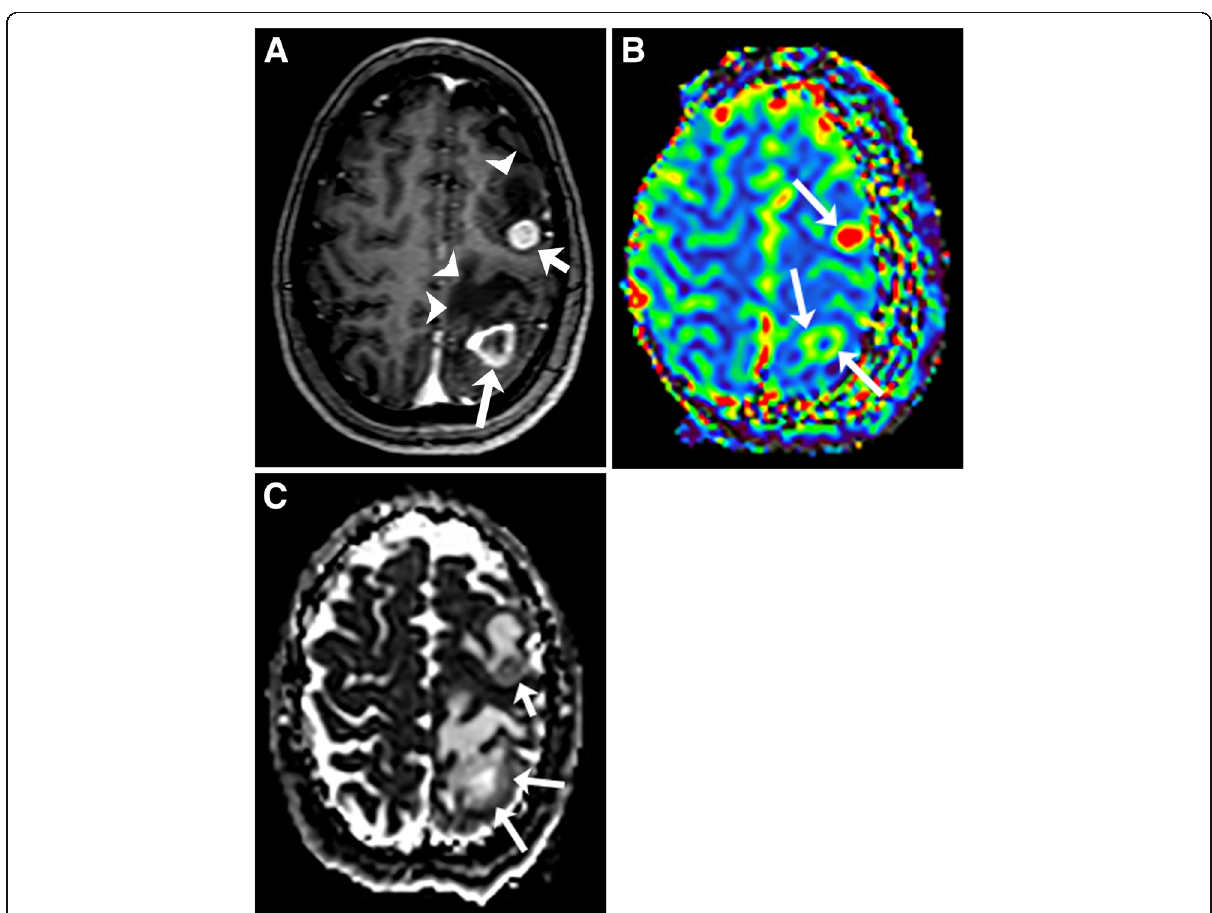
Fig. 11 Metastasis in a patient with lung adenocarcinoma. T1-weighted image with gadolinium ( a ) demonstrates a ring-enhancing left parietal lobe mass (long arrow) and a solidly enhancing left frontal lobe mass (short arrow). Extensive vasogenic edema is around each of these lesions (arrowheads). On CBV map ( b ), the CBV is elevated in the enhancing components (arrows). No increased peri-tumoral enhancement or elevated perfusion is present. ADC map ( c ) shows minimally decreased ADC in the parietal mass (long arrows) and mildly decreased ADC in the frontal mass (short